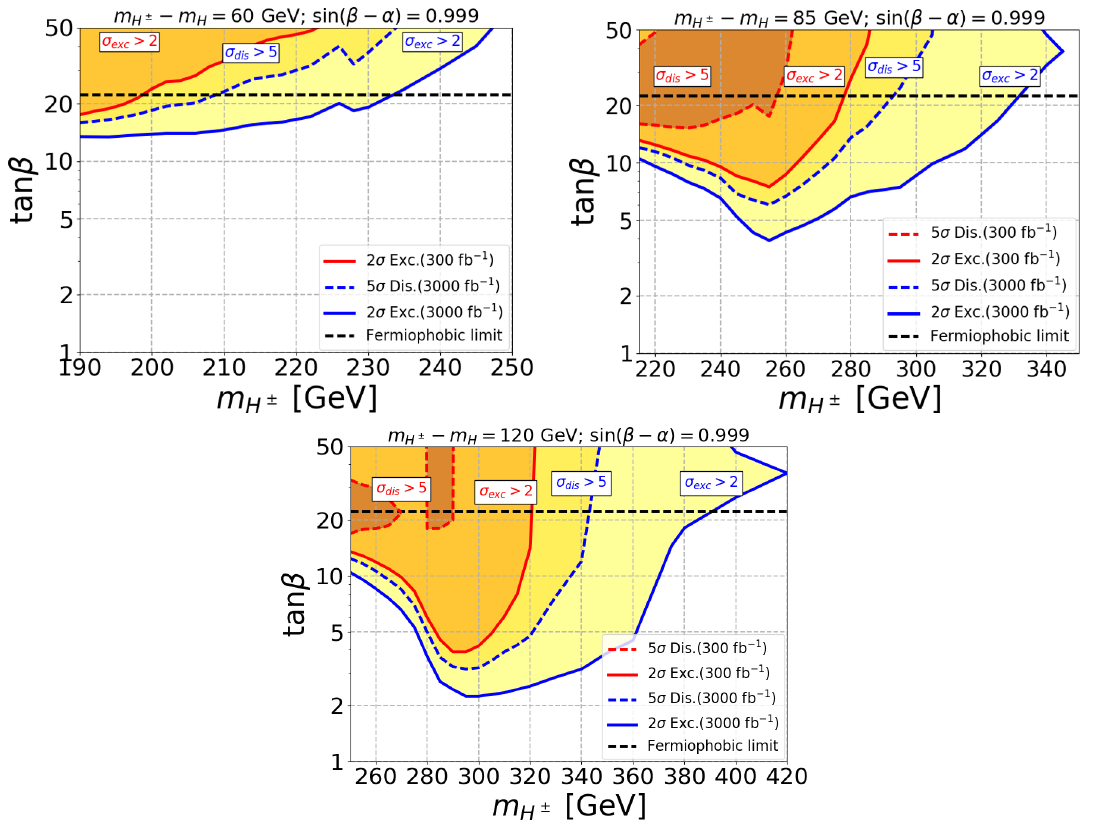
Figure 6 . Same as figure 5 with sin( β − α ) = 0 . 999